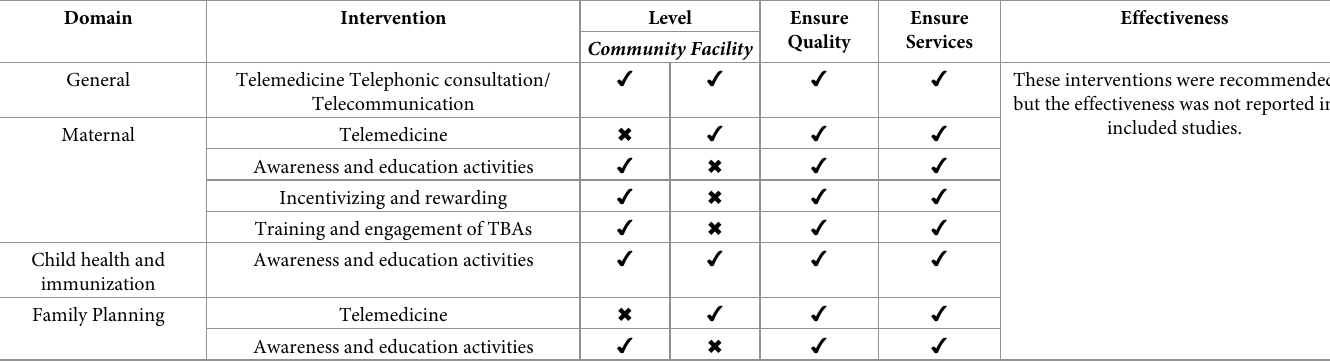
Table 2. Interventions to ensure MCH services with quality care during pandemic related health emergencies (Zika, Ebola and COVID-19). Domain